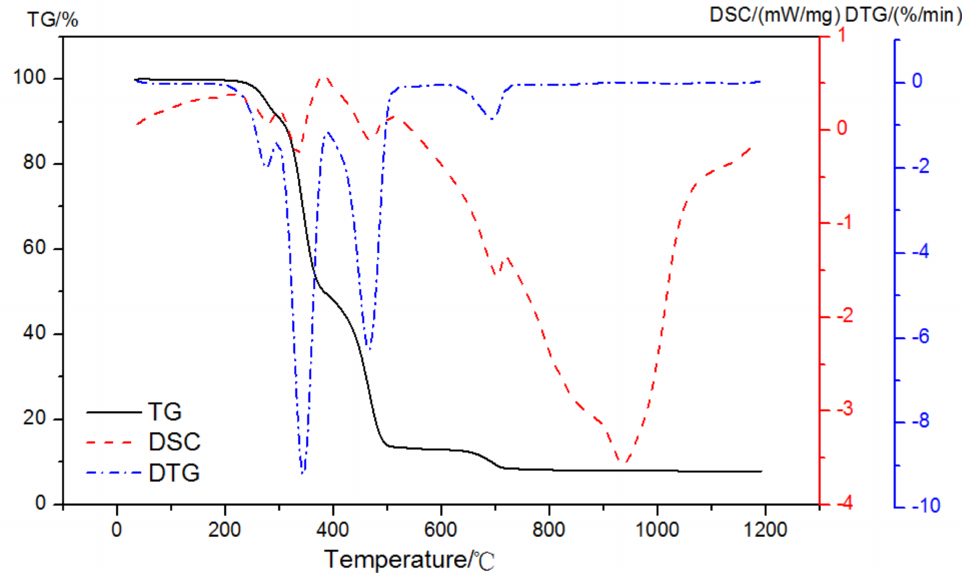
Figure 5. TG-DSC-DTG curves of EVA in a pure N 2 gas dynamic